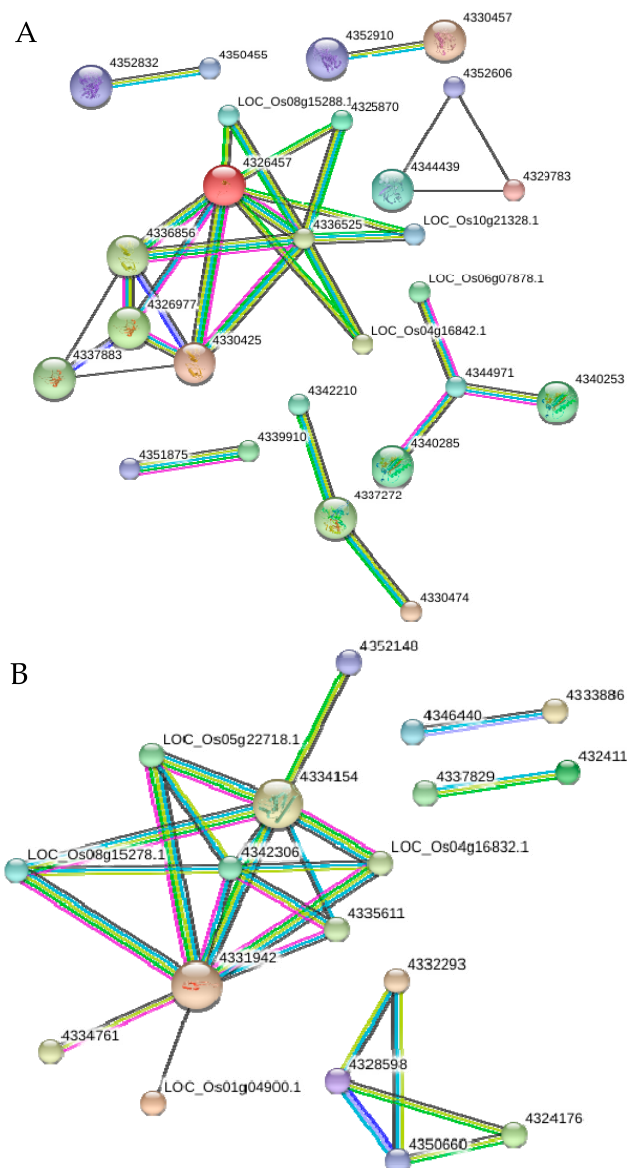
Figure 8. STRING software predicted differentially accumulated proteins association between herbicide quinclorac-treated only and salicylic acid + quinclorac treatment: ( A ) down-regulated and ( B ) up-regulated proteins. Differentially accumulated proteins are represented by node, whereas different color of lines represents different evidences for the predicted functional relationship between proteins; red line: gene fusion evidence; dark blue line: co-occurrence evidence; ml black line: co-expression evidence; yellow line: text-mining evidence; green line: neighborhood genome evidence; light blue line: database evidence; and pink line: experimental evidence. All interactions had a confidence score ≥ 0.9 (highest confidence) to minimize false positives/negatives.